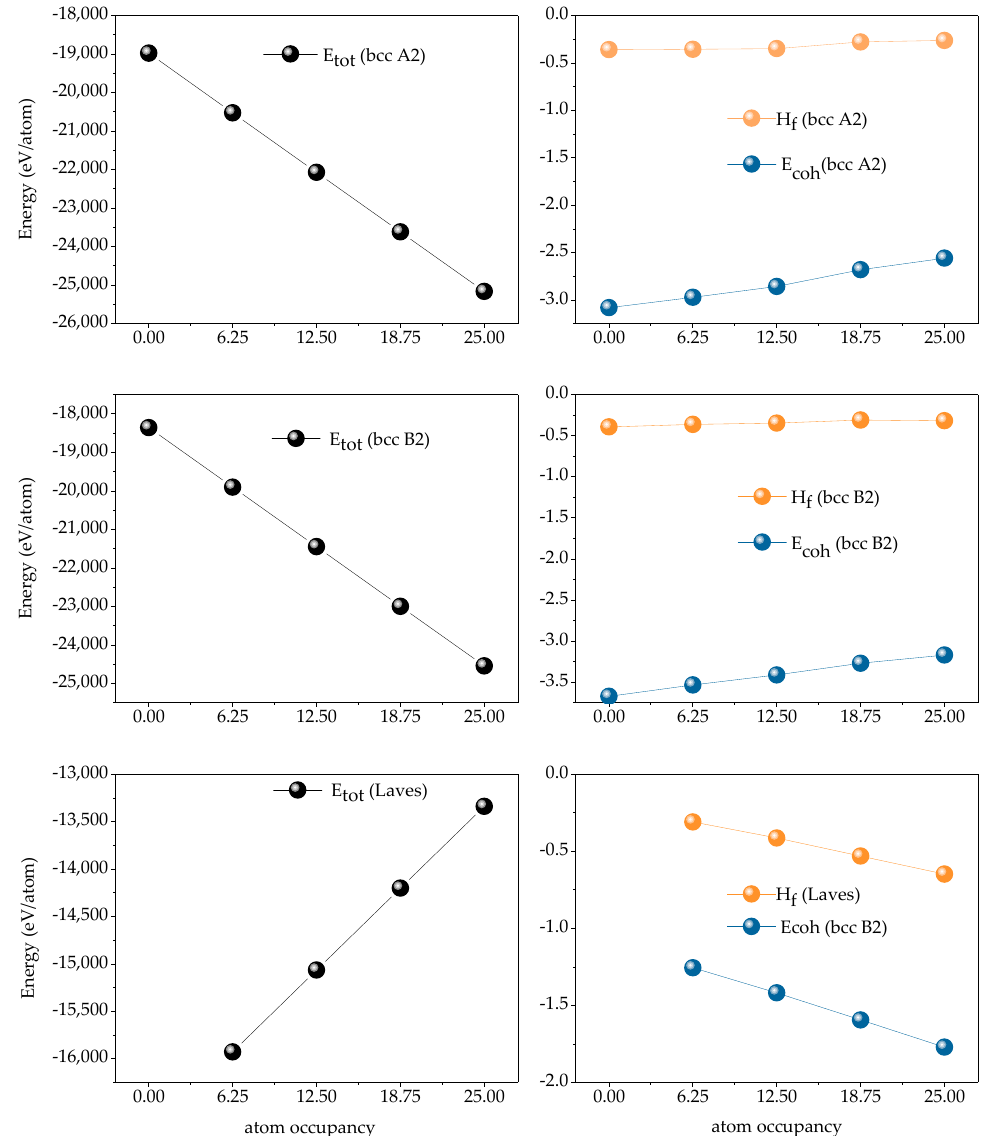
Figure 12. The total energy E tot , forming heat H f and bonding energy Ec of the Fe 25 Cr 25 Ni 25 Ti x Al (25 − x) system multi-principal element alloys.